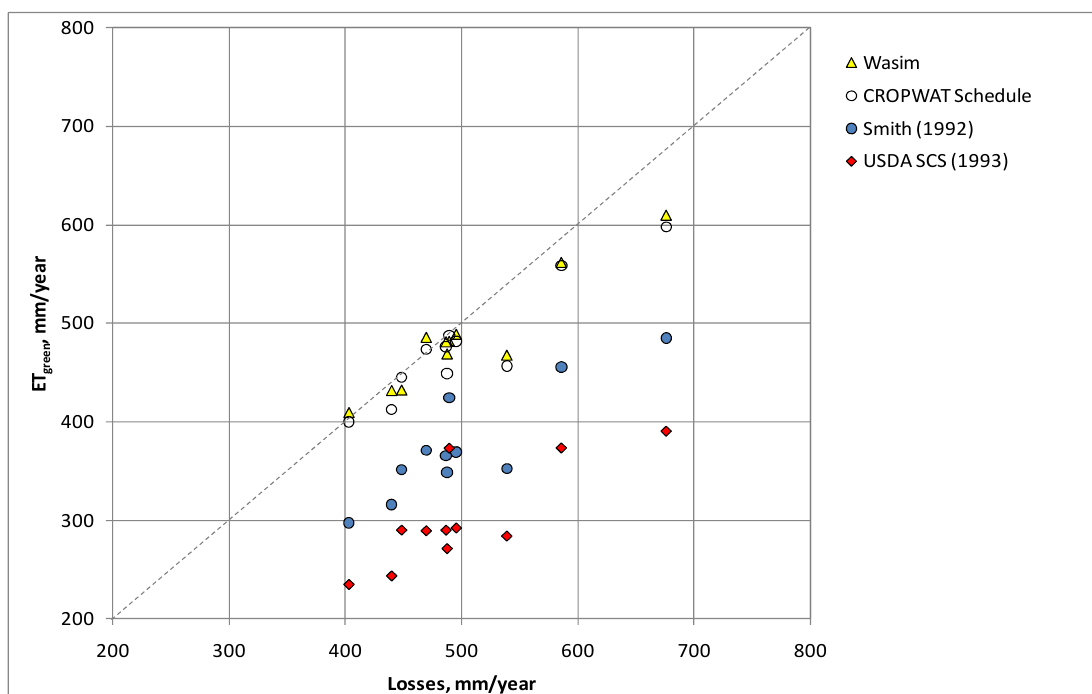
Figure 2. Comparison between average annual catchment losses and ET using four alternative approaches showing the 1:1 line